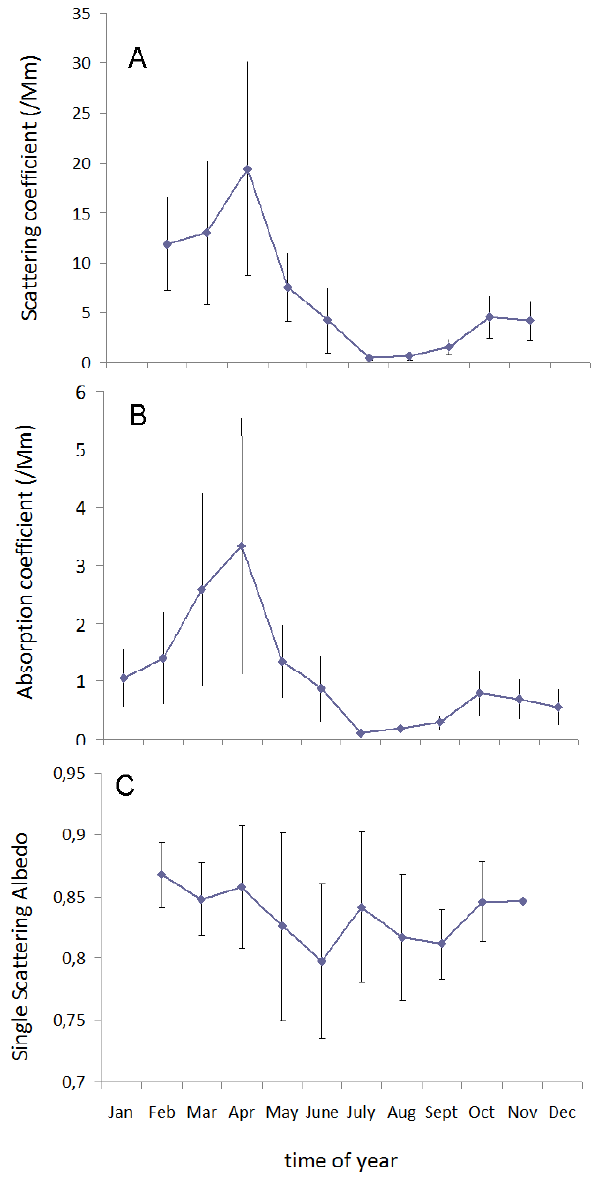
Fig. 1. Monthly averaged values of scattering coefficient (A) , ab- sorption coefficient (B) and single scattering albedo (C) measured at NCO-P. Error bars correspond to ± 1 standard